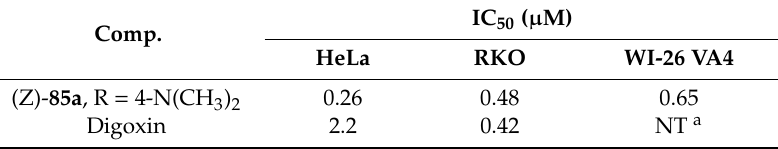
Figure 32. γ -Benzylidene derivatives of digoxin. Table 32. The antitumor activities of the digoxin derivative.